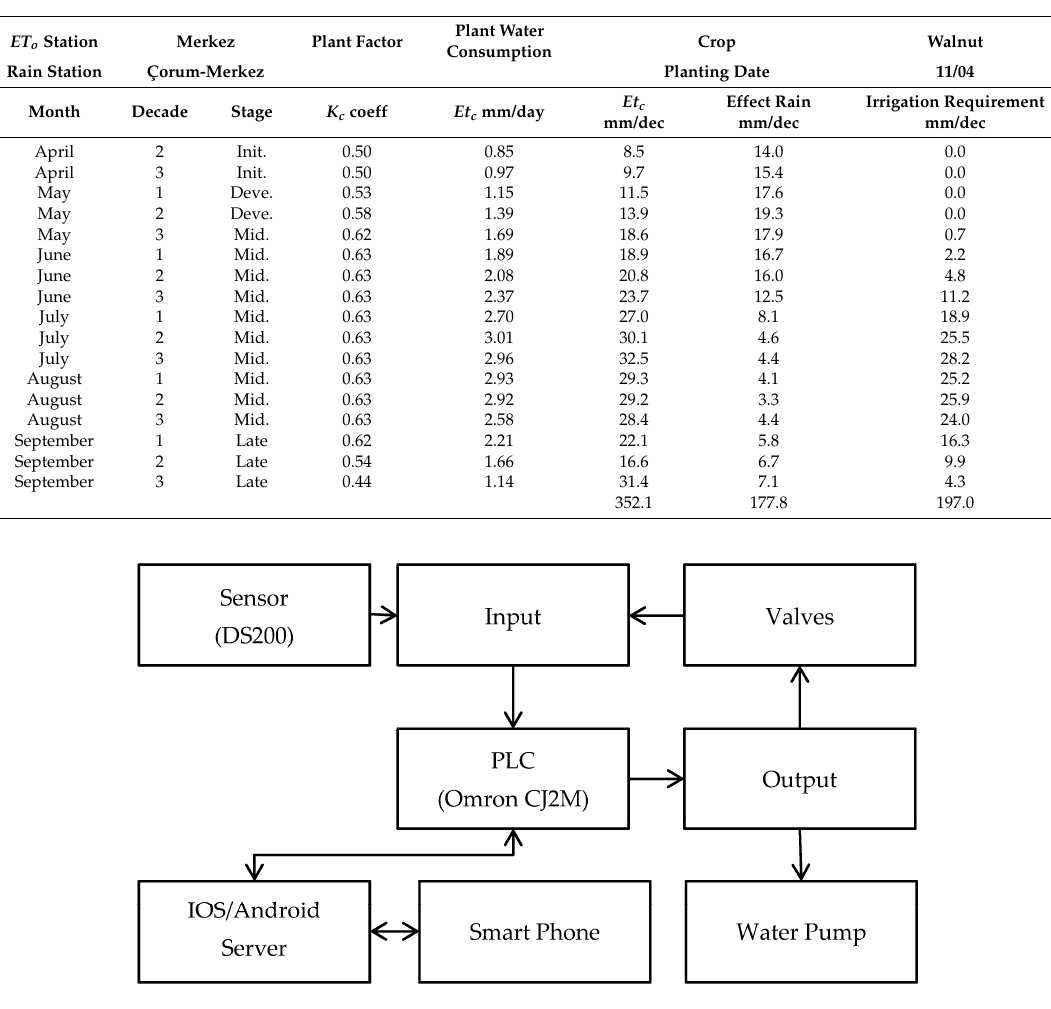
Figure 3. Control system diagram.